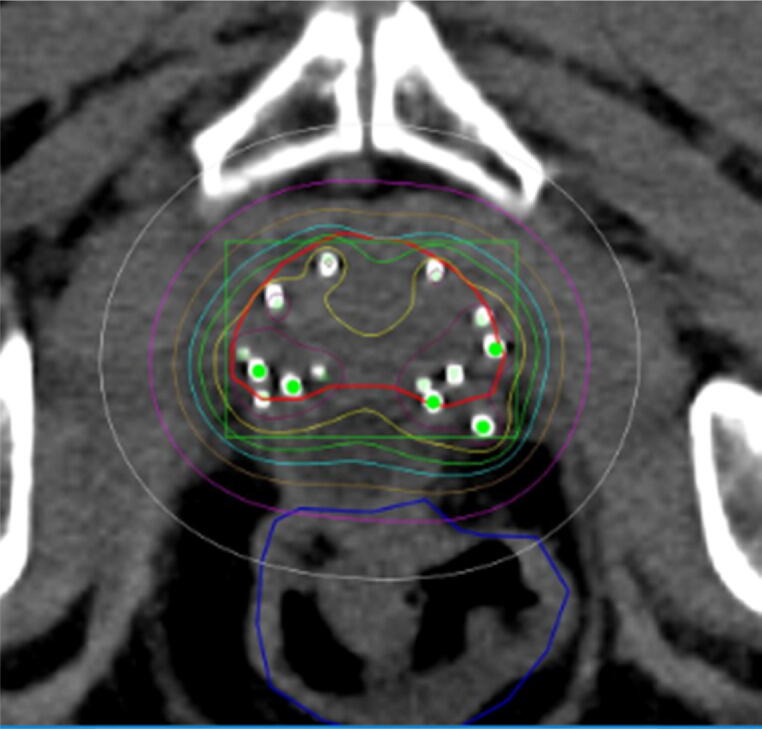
Isodose distribution in an axial CT plane after 125I brachytherapy implantation with a RBI. The prescribed dose to the prostate (red) was 145 Gy (green). The high-dose region >120% (yellow) and the low-dose region <40% (purple) with minimal overlap in the rectum (dark-blue). Abbreviation: RBI = Rectal Balloon Implant. (For interpretation of the references to color in this figure legend, the reader is referred to the web version of this article.)